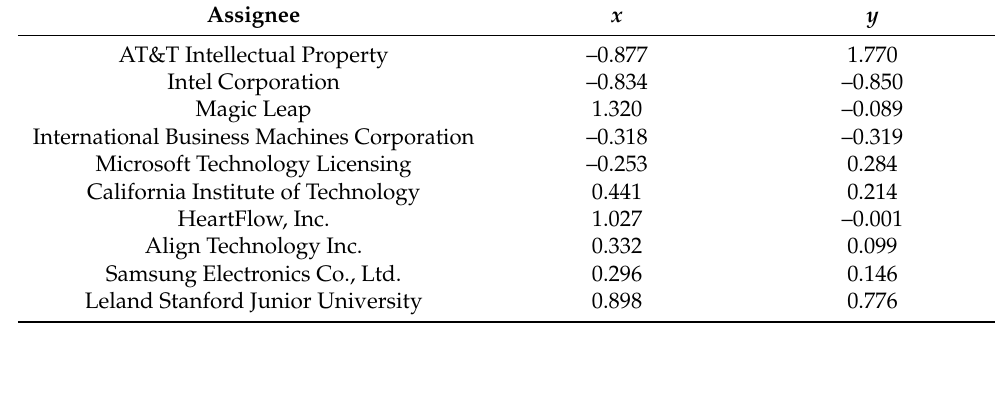
Table 3. Top ten assignees.